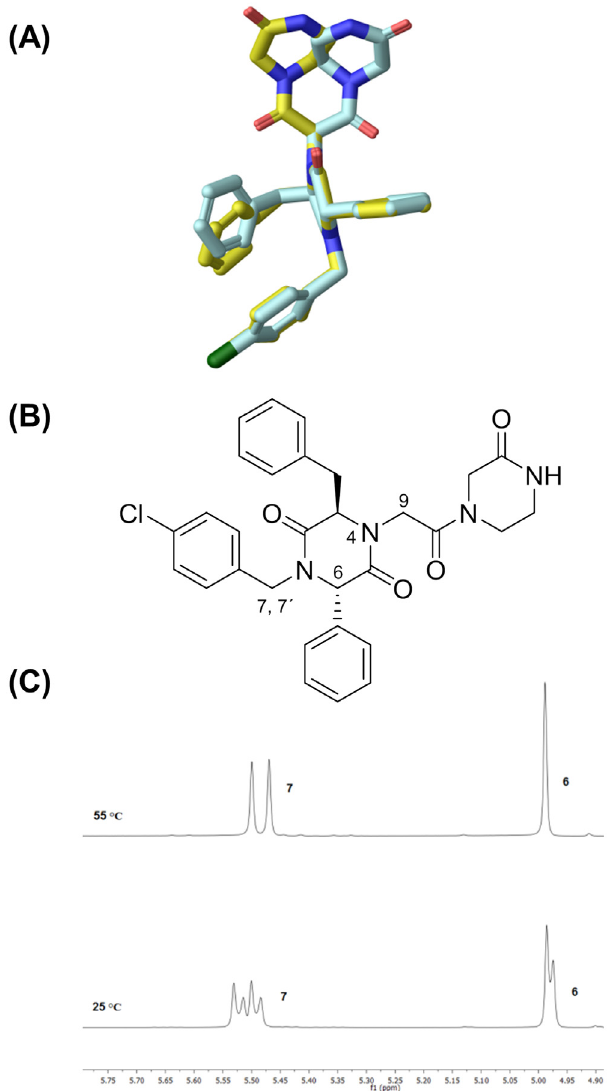
Fig 17. Conformational analysis of 57RS. ( A ) Model of two low energy conformations of 57RS ; ( B ) Chemical structure of 57RS with atom numbers; ( C ) 1 H NMR signals from H7 and H6 of 57RS at 25°C and